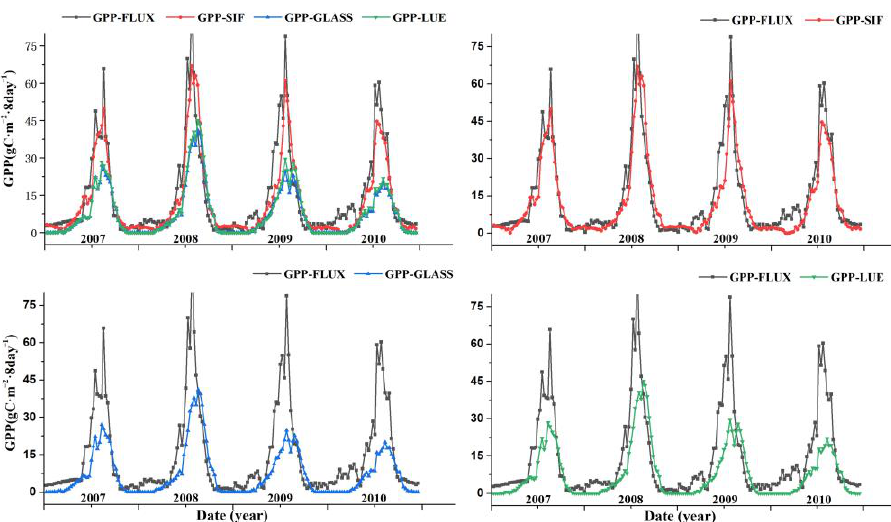
Figure 7. Comparison of GPP SIF , GPP GLASS , GPP LUE , and GPP FLUX data from 2007 – 2010.